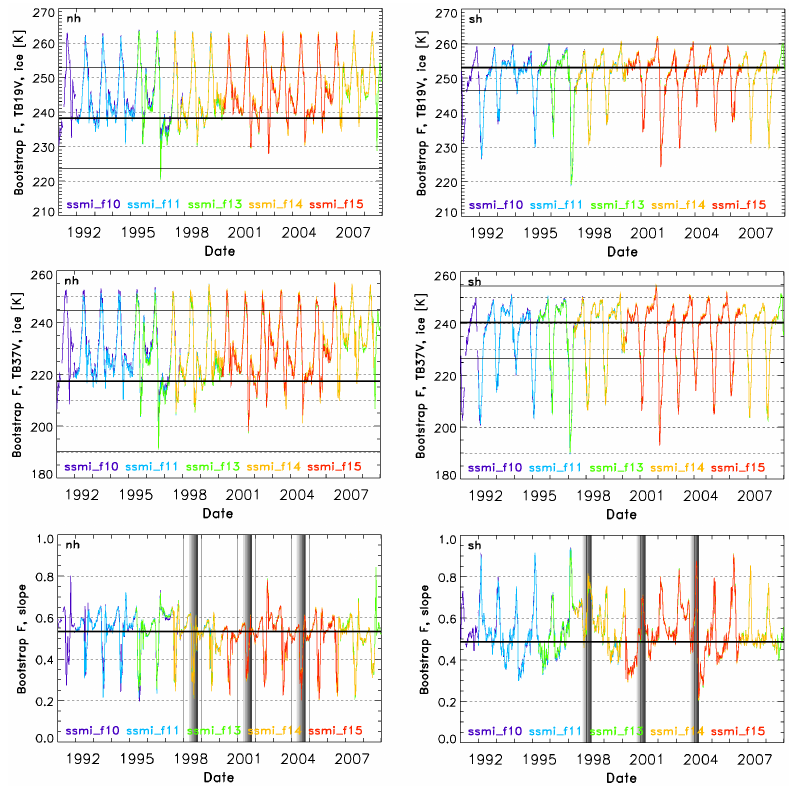
Figure 7. Examples of tie points time series for the Bootstrap F algorithm in the Northern Hemisphere (left panels) and in the Southern Hemisphere (right panels) (marked nh and sh respectively). Upper and middle panels show ice tie points Tb19V and Tb37V (brightness temperatures in 19V and 37V channels) respectively, and bottom panels show slopes. The vertical bars in light grey to dark grey colours denote the progressing melt season from May to September in the Northern and from November to March in the Southern